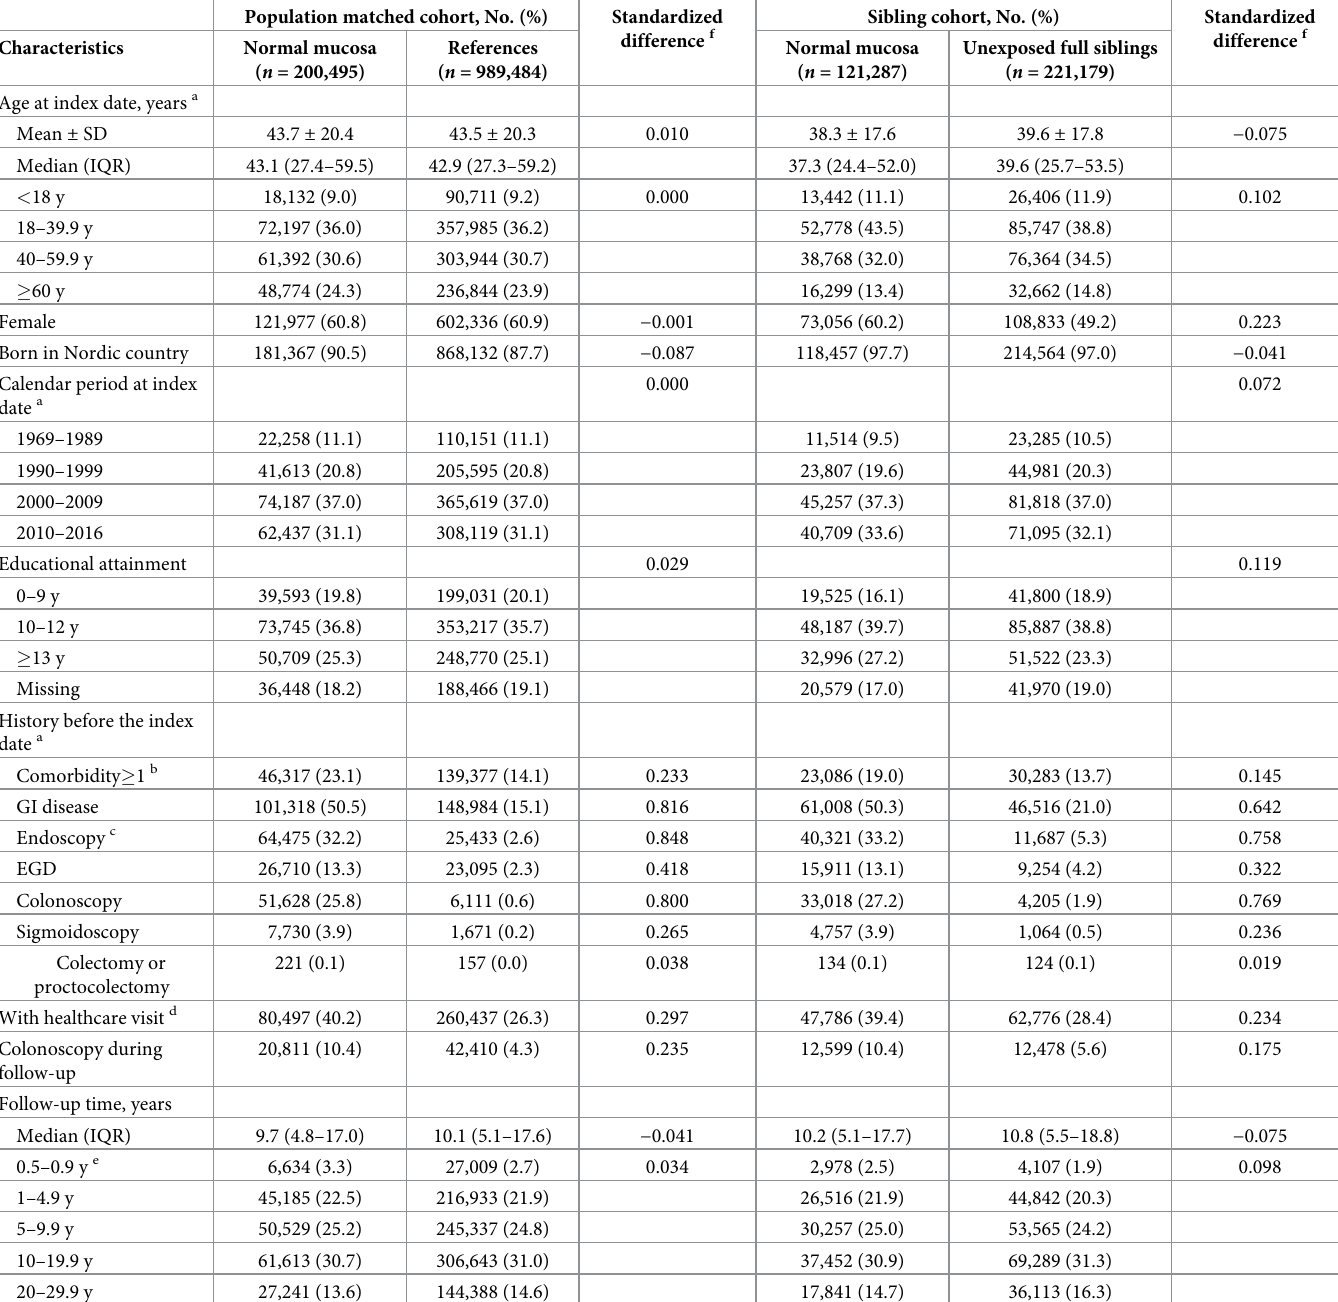
Table 1. Characteristics of individuals with a lower GI biopsy of normal mucosa and their matched population references and unexposed full